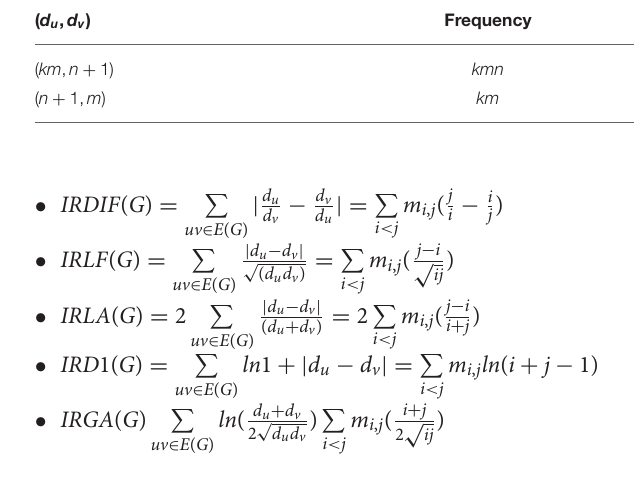
TABLE 1 | E[ PNN ( n , k , m